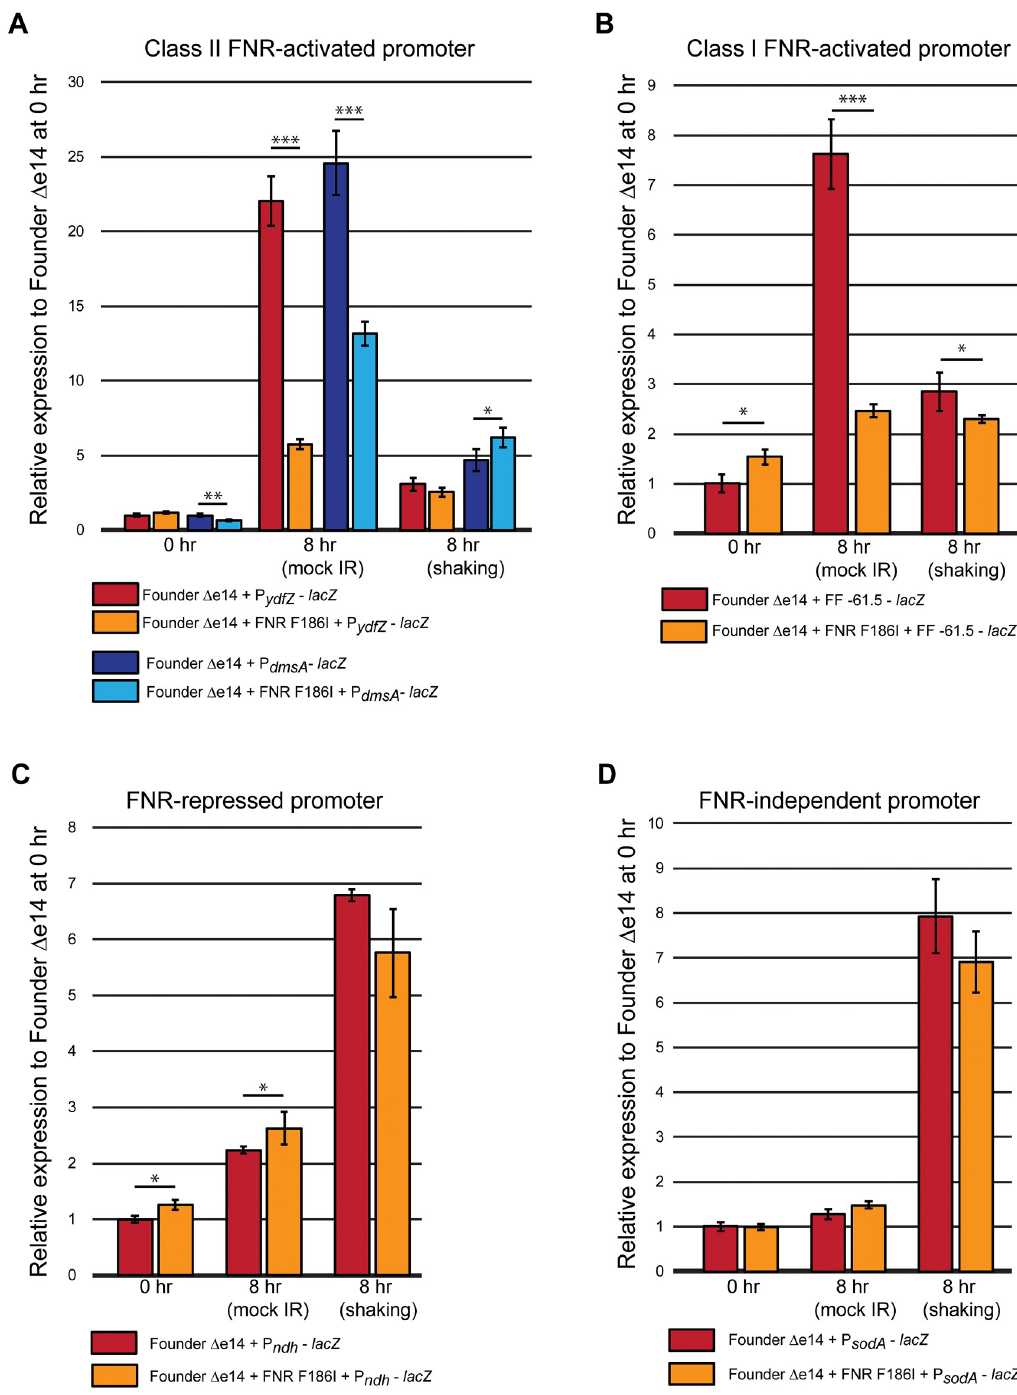
Fig 3. β -galactosidase activity of promoter- lacZ fusions in Founder Δ e14 + FNR F186I. β -galactosidase activity was assayed in conditions mimicking irradiation assays (exponential phase cells aliquoted in a 1.5 mL tube and incubated at room temperature for 8 hr) with and without shaking. β -gal activity was normalized to the average β -gal activity of Founder Δ e14 with the appropriate lacZ fusion (containing the wild-type FNR F186I allele) at the 0 hr time point (prior to start 8 hr incubations). These fusions have been previously described [16, 18–20]. The β -galactosidase assay was carried out as described in the Materials in Methods section. These data represent the results of two independent experiments carried out in biological triplicate or duplicate for the repeat experiment. Statistical significance was determined using a two-tailed Student’s t-test. P-values are indicated using the ‘ � ’ (p < 0.05), ‘ �� ’ (p < 0.01), and ‘ ��� ’ (p < 0.001) symbols. Data for these experiments are contained in the Supporting Information (S3 File. Beta-galactosidase raw